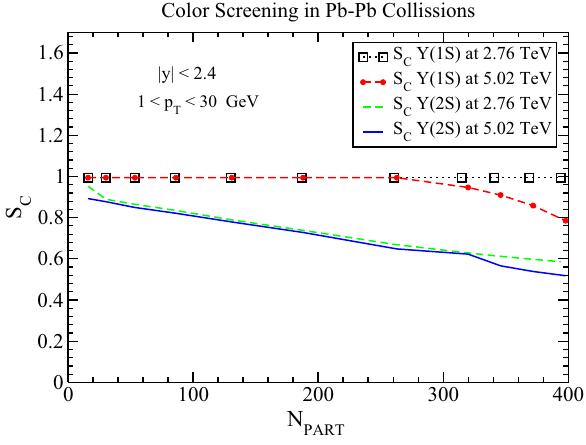
Fig. 4 Color screening for ϒ( 1 S ) and ϒ( 2 S ) versus N PART in Pb–Pb Collisions at LHC